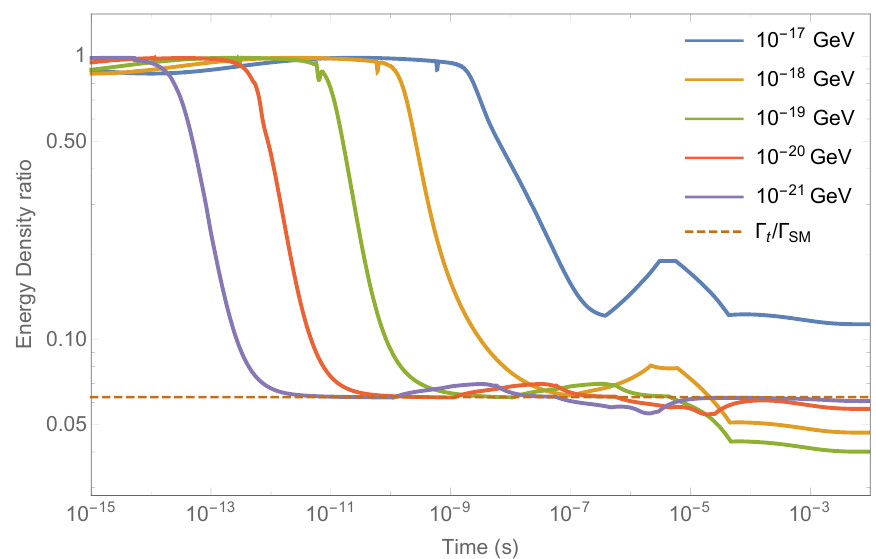
Figure 7 . Ratio of twin to SM energy densities throughout decoupling and reheating, for di(cid:11)erent decay rates (cid:0) X . The dashed line corresponds to the prediction of from the ratio of decay widths, here selected to be 1 =